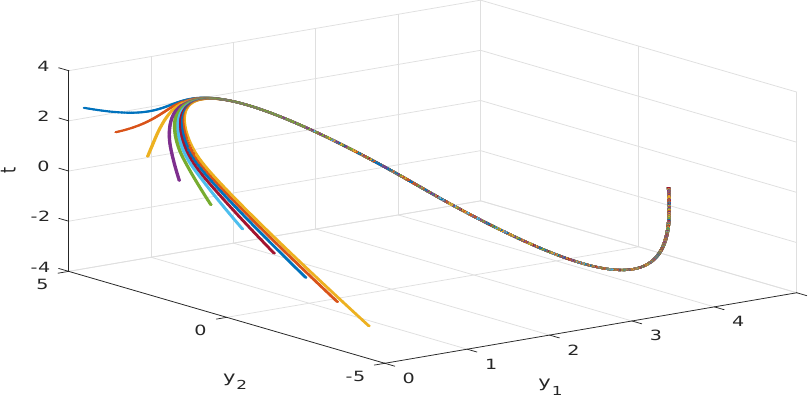
Figure 4. An illustration of the time responses between the imaginary subspace pertaining to the model in (20), in which ˜ u ( t ) = sin ( 0.02 t ) e − 0.005 t in Example 1.